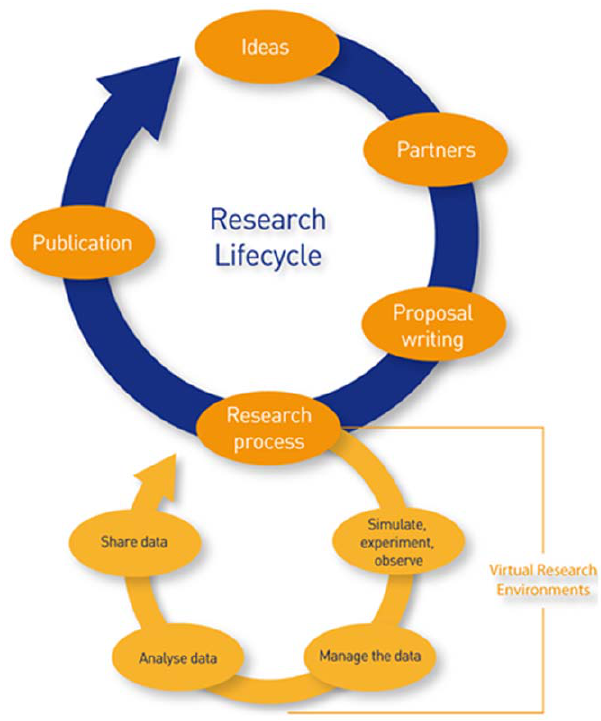
Figure 1. Joint Information Systems Committee (JISC), Stages of the research and data